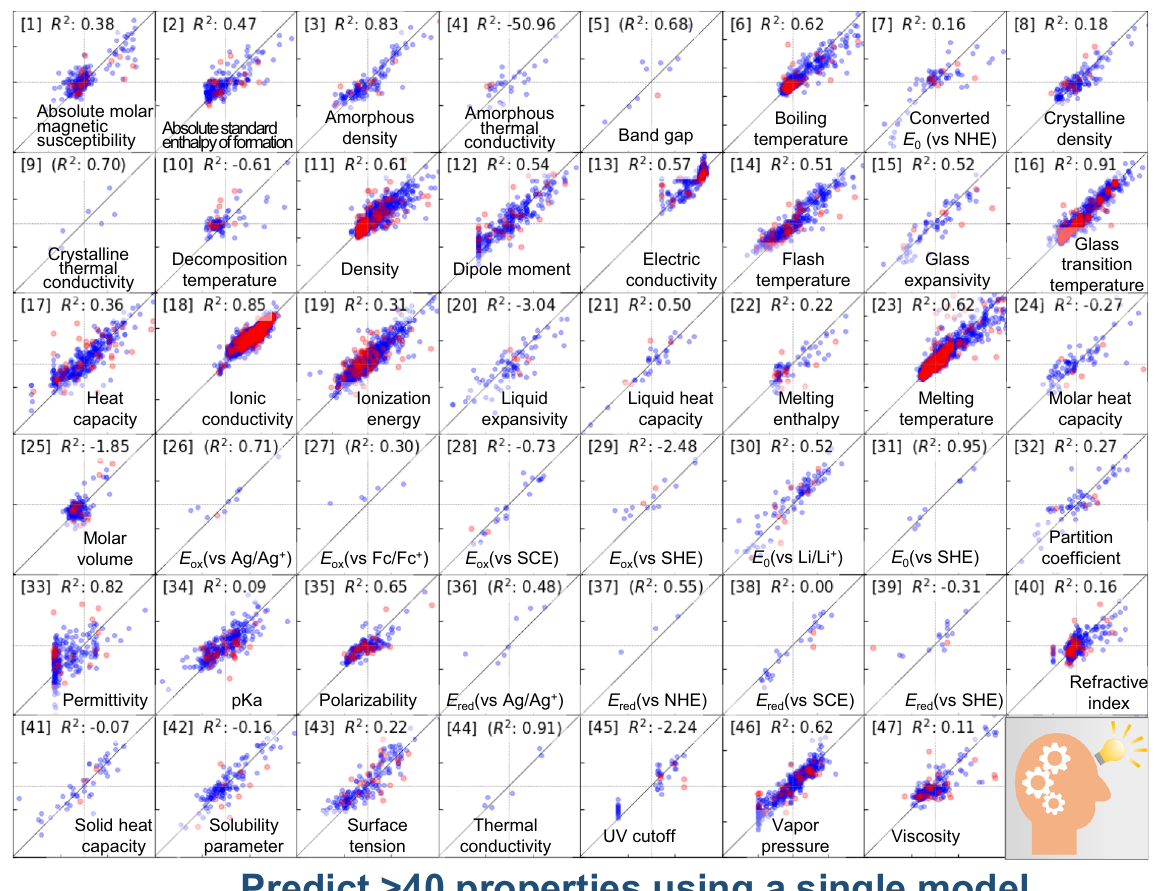
Fig. 5 Prediction of versatile parameters. Experimental ( x -axis) and predicted ( y -axis) values of each parameter after multitask learning of the 14 databases (90% of data was used for training). Blue and red plots correspond to the training and test datasets, respectively. The values are shown as z -scores. R 2 scores for test datasets are displayed. If test cases were not enough for evaluation, train scores are shown with brackets instead. Statistical results are also summarized in Supplementary Table 1. Larger graphs are shown in Supplementary Fig.